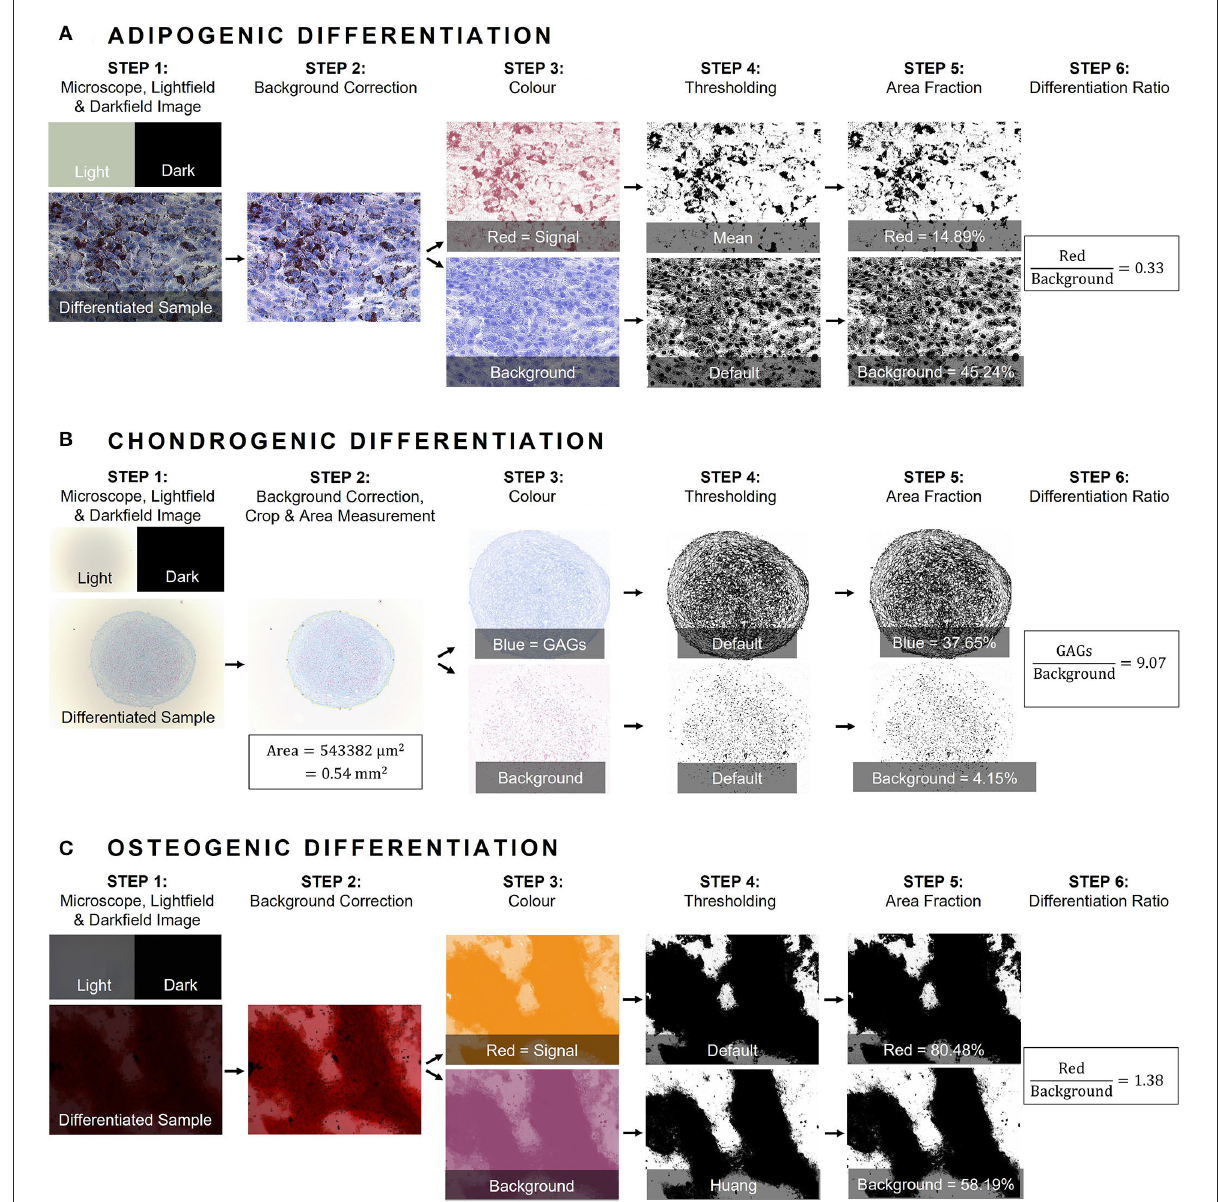
FIGURE1 General workflow of image analysis using color deconvolution in ImageJ. (A) Adipogenic differentiation was confirmed with Oil Red O histological staining and Mayer’s modified hematoxylin counterstaining, (B) Chondrogenic differentiation with Alcian Blue histological staining and Nuclear Fast Red counterstaining. Additionally, in step 2 chondrogenic pellet size (area in mm 2 ) was measured, and (C) Osteogenic differentiation was confirmed with Alizarin Red staining. In general, a darkfield image (called “Dark”) was obtained with a closed illumination path to correct for any fixed pattern noise (step 1). Subsequently, an image of an empty well was captured as “brightfield” (called “Light”) to correct for varying background illumination (step 1). As such, images were corrected prior to image analysis for background illumination and transmittance through the well (step 2). Next, a threshold for differentiation was determined for each histological staining and separated from the second component either nuclear signal or cell culture area (step 3). Per sample, two channels were established and quantified using “ Thresholding ” (step 4). Finally, the area fraction of the differentiation channel was measured in the binarized image and divided by the area fraction of the counterpart (step 5 and 6). GAGs, glycosaminoglycans.